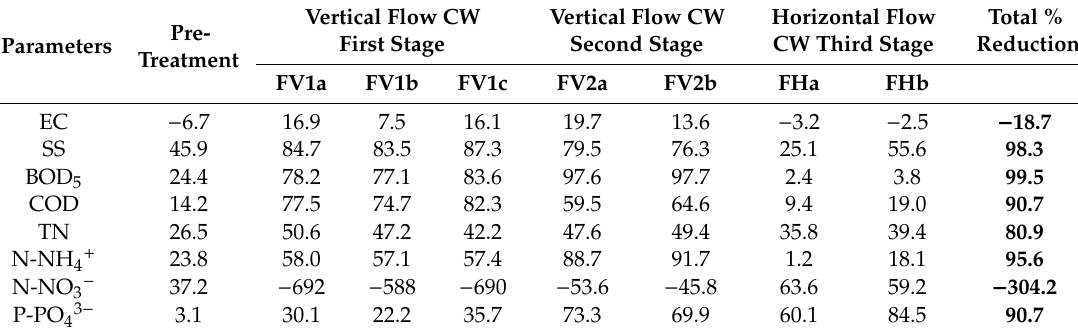
Table 4. Multistage CW performance: percentage removal of pollutants ( n =